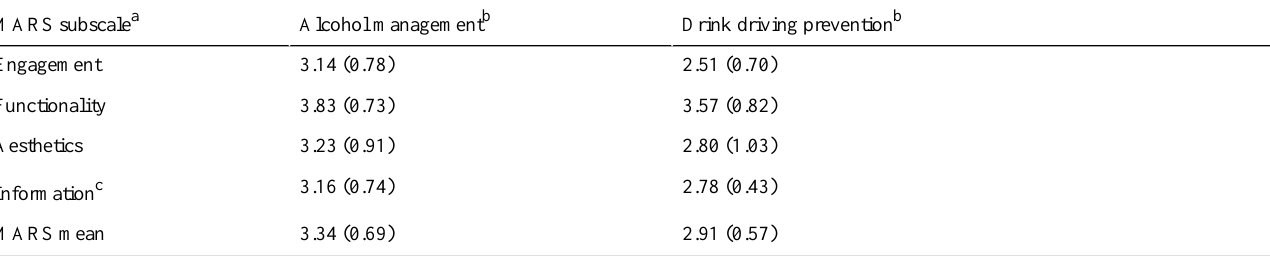
Table 2. Comparison of MARS subscale means and standard deviations in parenthesis, between alcohol management and drink driving prevention